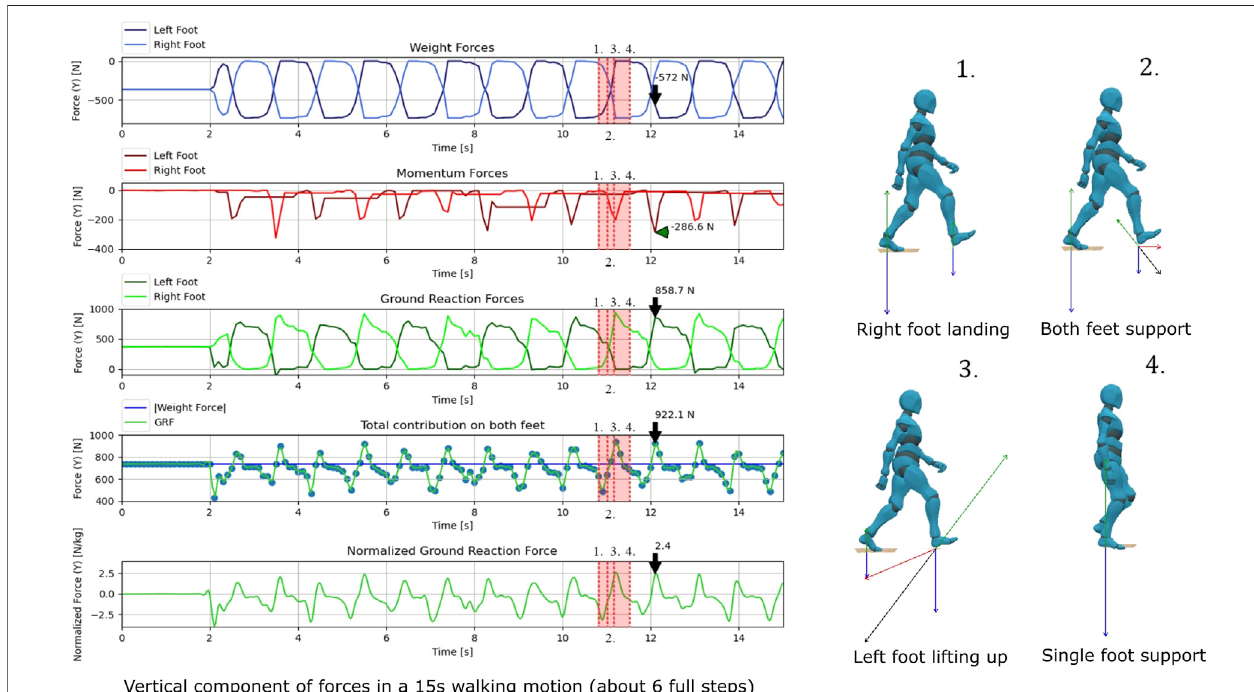
FIGURE 6 | Graph of forces during a walking animation. The green marker in the plot of the second row represents the moment at which the force due to the changeinmomentumreachesitsmaximumvalue. Thissametime isshown bytheblack arrowintheotherplotsand showstheassociatedGRFmaximalvalue.Thefour main events happening before and during the foot contact in the walking cycle are indicated by numbers 1 – 4 and illustrated on the right side.